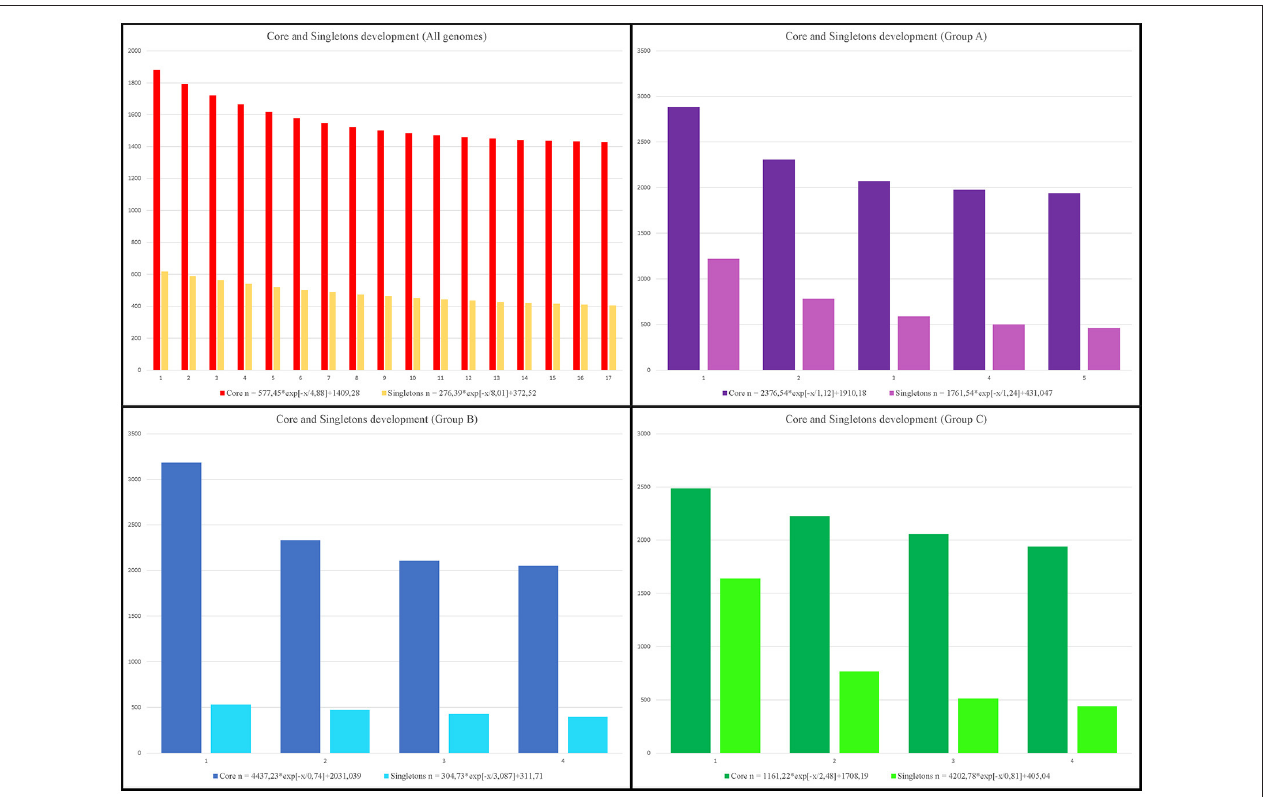
FIGURE 7 | Development of core genome and singletons. Upper left chart: core-genome and singleton development based on permutations of all 17 genomes of Faecalibacterium . Upper right chart: development based on permutations of 5 genomes from group A. Lower left chart: development based on permutations of 4 genomes from group B. Lower right chart: development based on permutations of 4 genomes from group C.